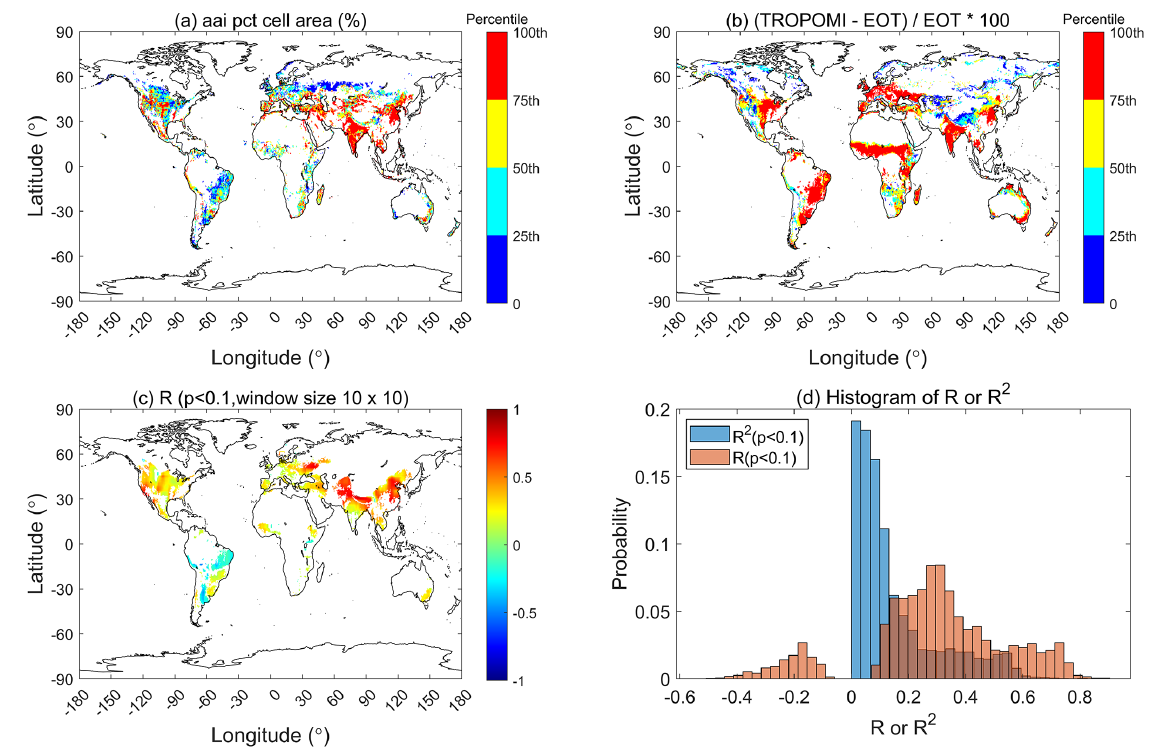
Figure 4. The influence of irrigation on V cmax over cropland and grassland, detected by TROPOMI SIF + LCC at 0.5 ◦ resolution, where (a) is the actual area irrigated in percent of cell area (aai pct cell area) in recent decades, (b) the relative difference in V cmax ( (cid:49)V cmax ) between TROPOMI and ecological optimality theory (EOT), i.e., (cid:49)V cmax = (TROPOMI-EOT)/EOT, (c) the correlation coefficient ( r ) between actual irrigated area percentage and (cid:49)V cmax within sliding windows of 10 × 10pixels, and (d) the histograms of r and R 2 values in (c) for cropland and grassland. (cid:49)V cmax is significantly correlated with percent area irrigated in both cropland ( r = 0 . 32, p< 0 . 001) and grassland ( r = 0 . 30, p< 0 . 001) at the global